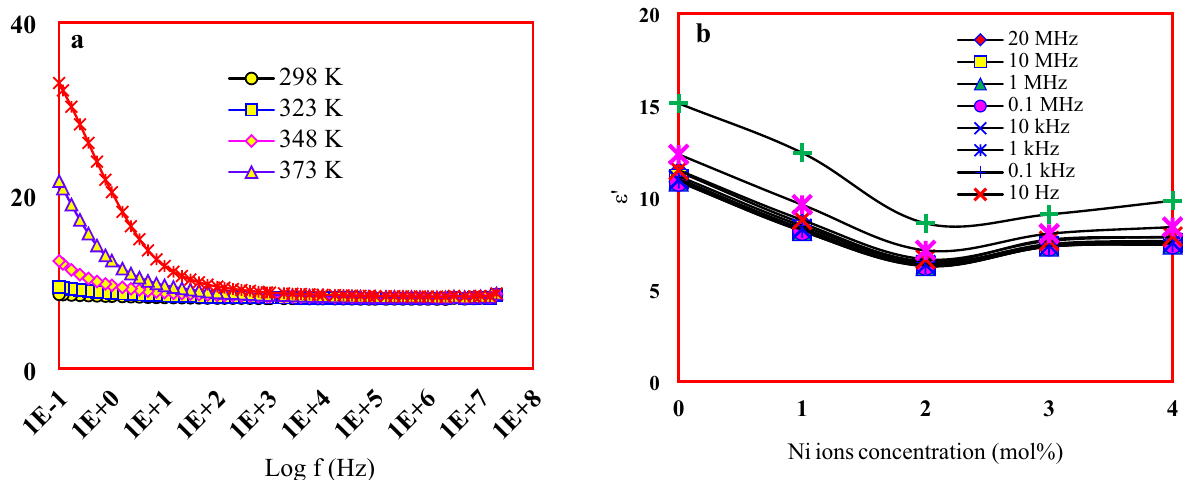
Figure 8. ( a ) Dielectric constant dependence on temperature and frequency and ( b ) Variation of dielectric constant with Ni